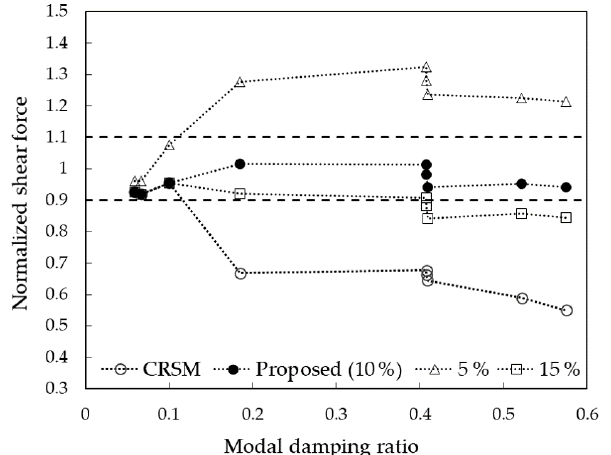
Figure 8. Normalized shear force on the footing for different modal damping